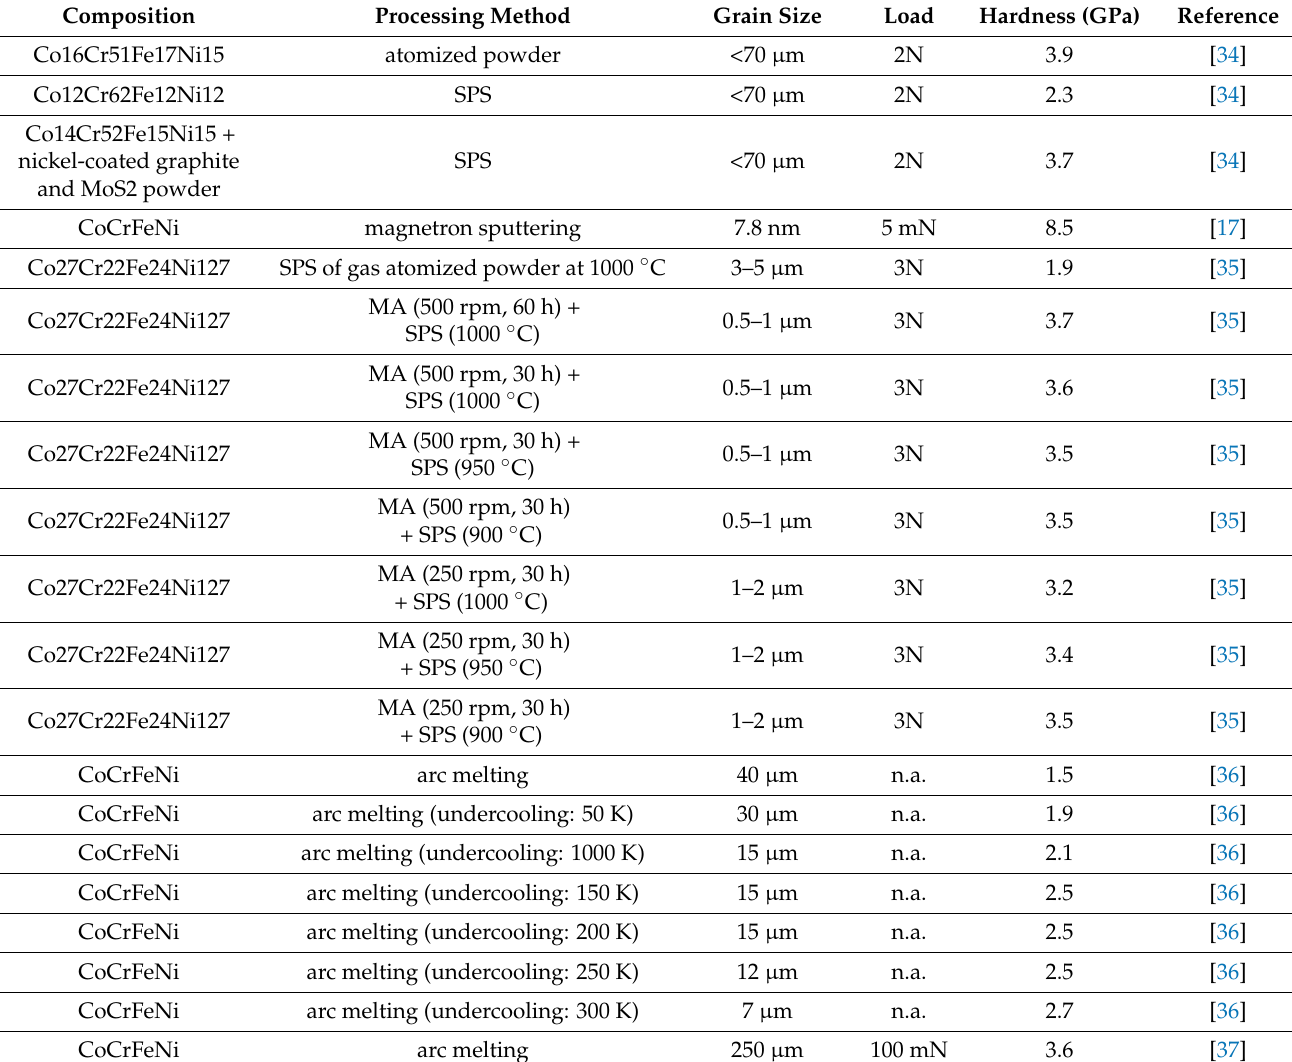
Table 4. The hardness reported in the literature on materials in the Co-Cr-Ni-Fe system. SPS: spark plasma sintering; MA: mechanical